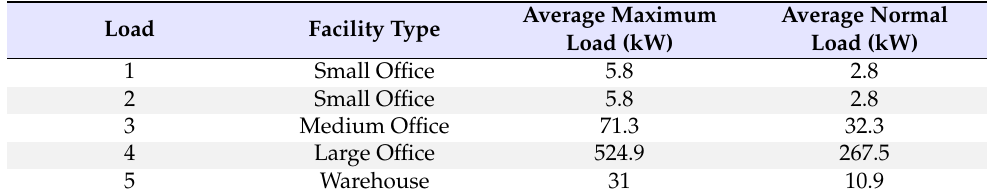
Table 1. Building Load Data. This data is derived from the DOE Commercial Reference Building dataset hourly load data [56]. This data is used to extract the average maximum load and average normal load for associate facility